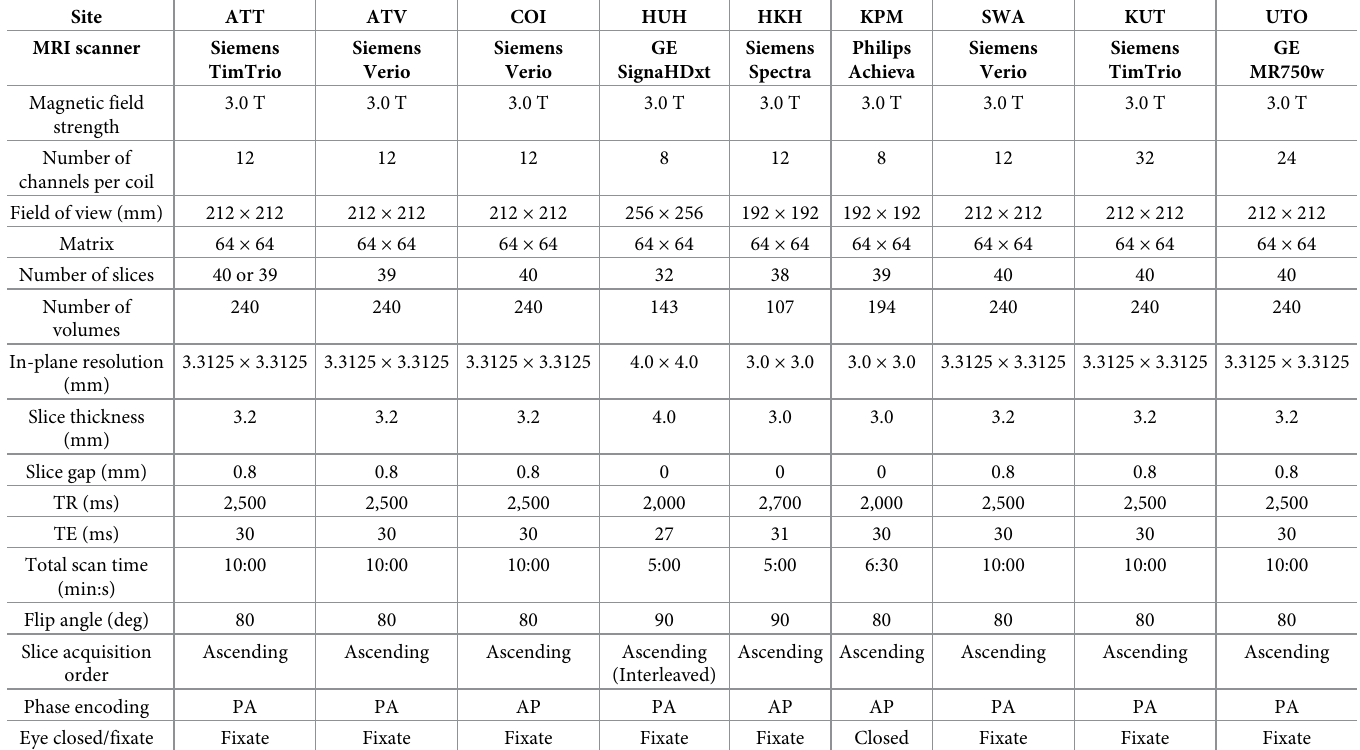
Table 2. Imaging protocols for resting-state fMRI in the SRPBS multidisorder